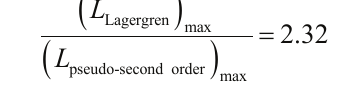
Fig. 4 – Comparison of the experimental data and calculated results for Zn sorption on normal coal fly ash